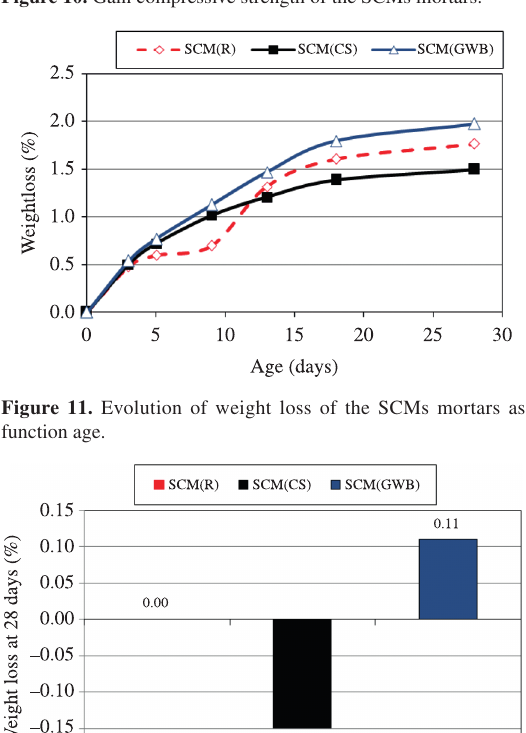
Figure 10. Gain compressive strength of the SCMs mortars.